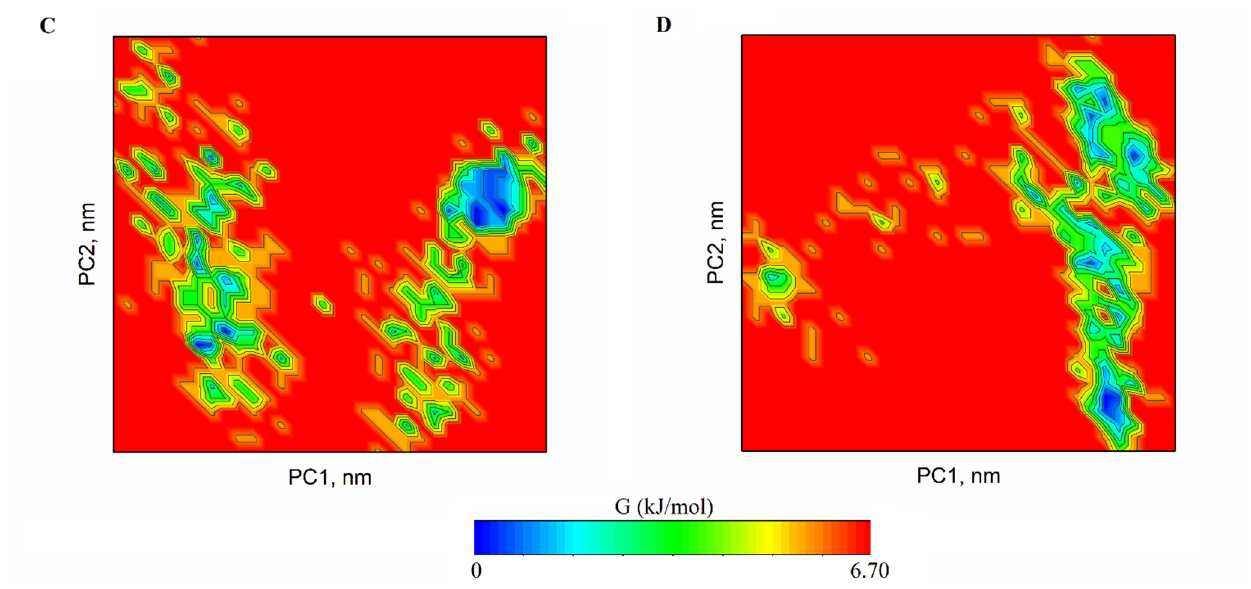
Figure 6. Projection in phase space and FELs of the two systems. FELs as a function of the projection of PC1 and PC2 onto the essential subspace of the PPAR γ -RXR α system ( A ) and the PPAR γ -RXR α - DNA system ( B ). Projection of the motion in the phase space along the first and second eigenvectors (PC2 versus PC1) for the PPAR γ -RXR α system ( C ) and the PPAR γ -RXR α -DNA system ( D ). The color bar represents the relative free energy value in kcal/mol.